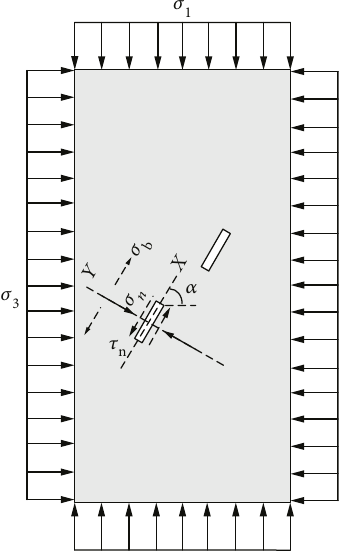
fl awed specimens. us of pre